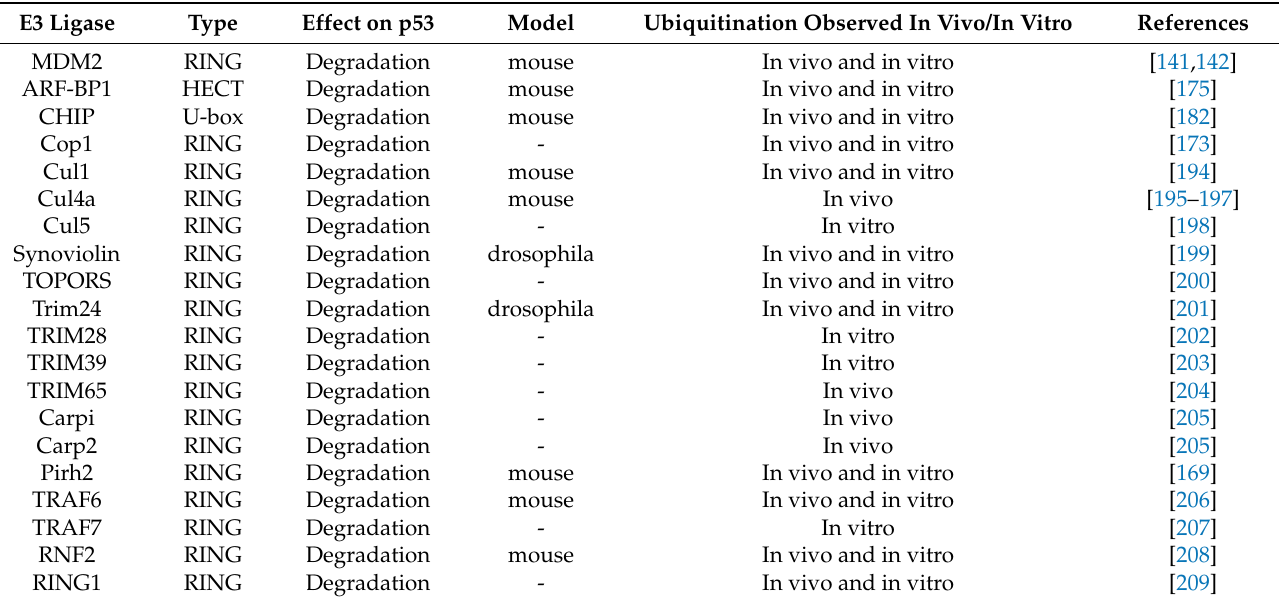
Table 1. Ubiquitin E3 ligases targeting p53 for